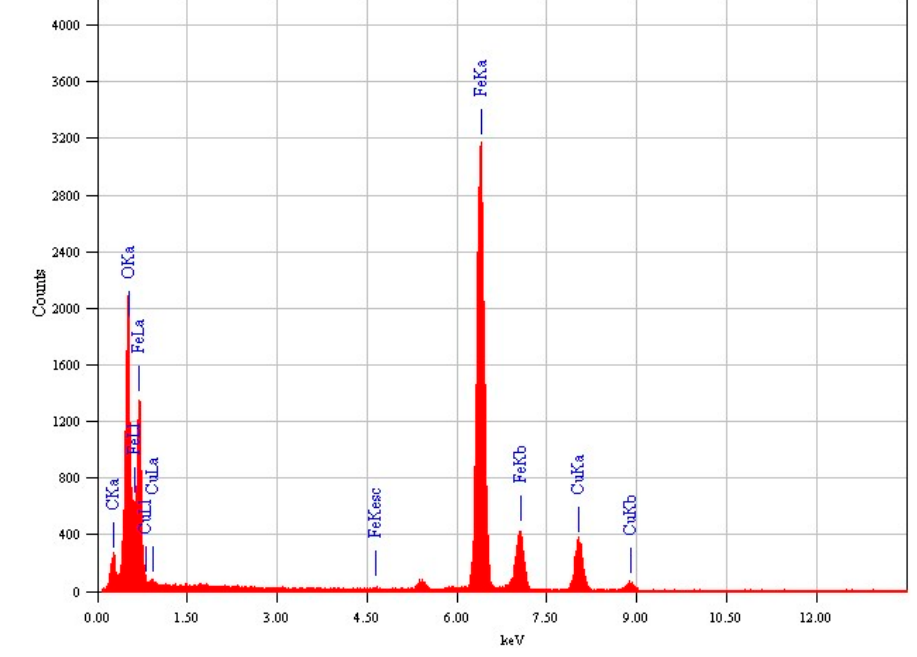
Figure 3. EDX spectrum of Fe 3 O 4 /RGO/PEG nanocomposite.